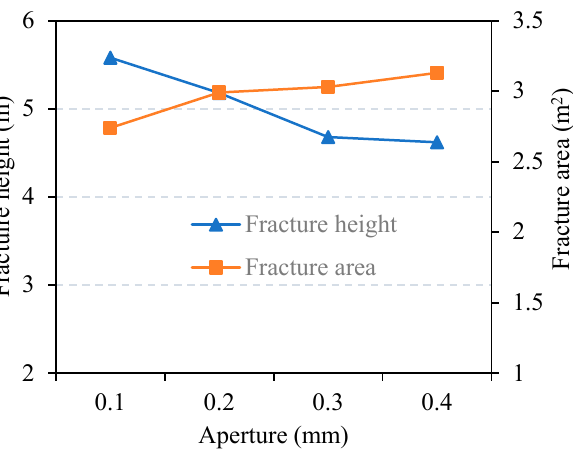
Figure 17. Variation in fracture height and fracture area versus bedding aperture.